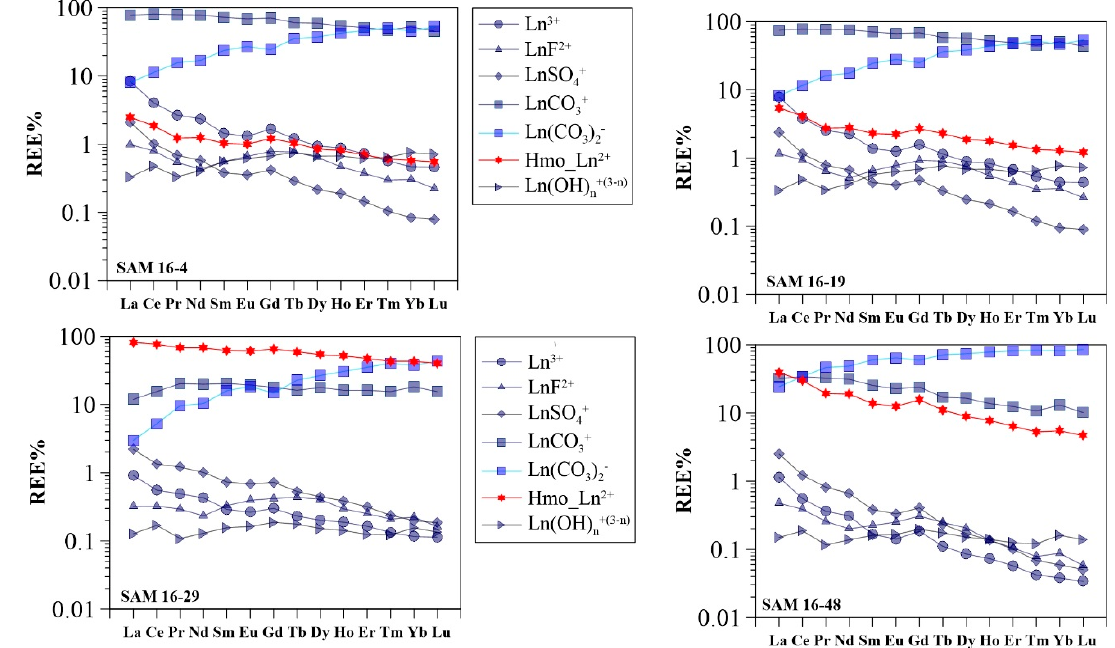
Figure 5. Results of speciation modeling of the REE in groundwater samples (Ln represents any of the REEs).